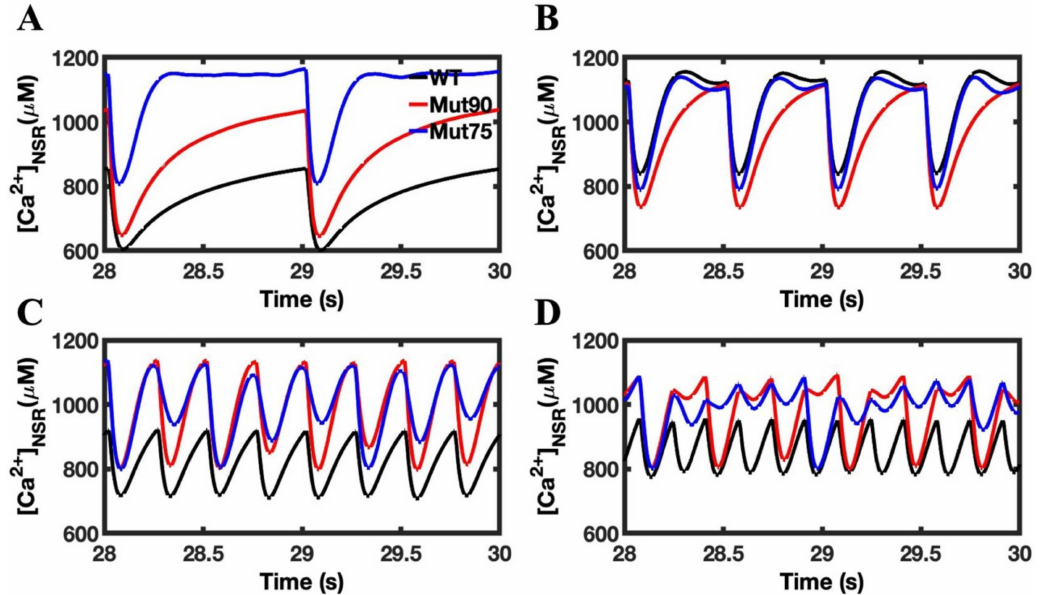
Figure 11. NSR calcium in beta-adrenergic stimulated cardiac myocytes: ( A ) 1 Hz pacing, ( B ) 2 Hz pacing, ( C ) 4 Hz pacing, ( D ) 6 Hz pacing. The wild-type cardiac myocytes (black) show consistent morphology with increased pacing. The mutant simulations CDI (75% of transition rate—blue and 90% of transition rate—red) of the cardiac myocyte show that in beta-adrenergic cardiac myocytes, the NSR calcium dynamics of CDI mutants become severely disrupted in response to pacing. Shown are representative simulations out of six repeated simulations with different random number seed values in each case. The different simulation traces for each condition overlap at steady-state